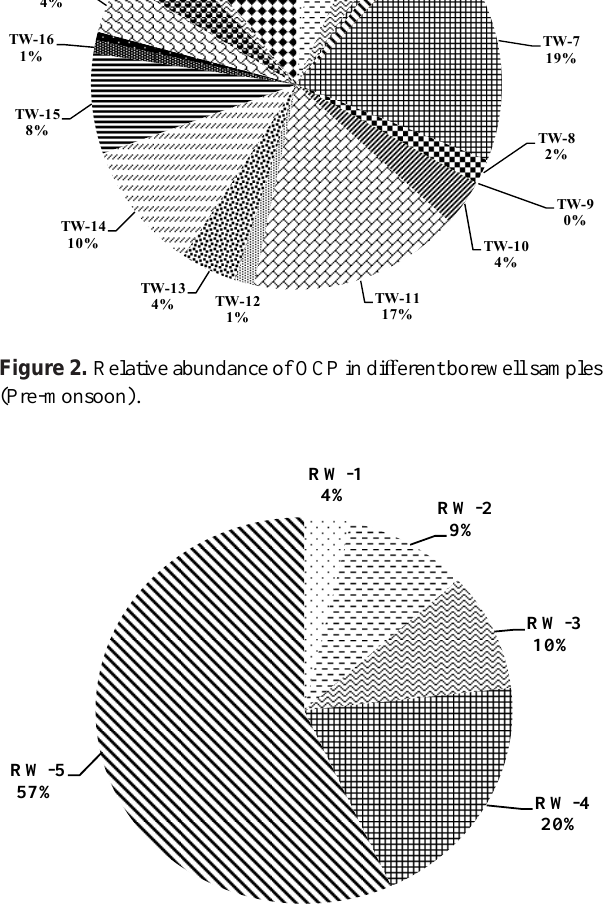
Figure 3. Relative abundance of OCP in different Ranney well samples (Pre-monsoon).